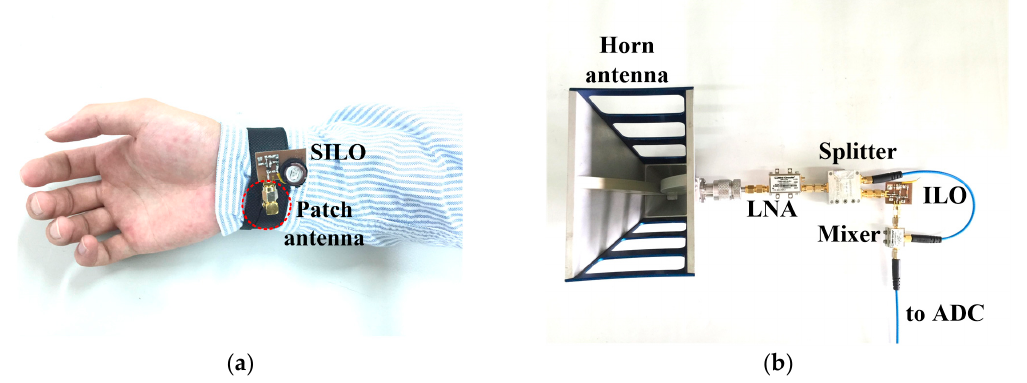
Figure 9. Photograph of the wrist pulse rate monitor. ( a ) Active antenna wristband; ( b ) Frequency discriminator. Table 2. List of components used in the wrist-worn pulse rate monitor.